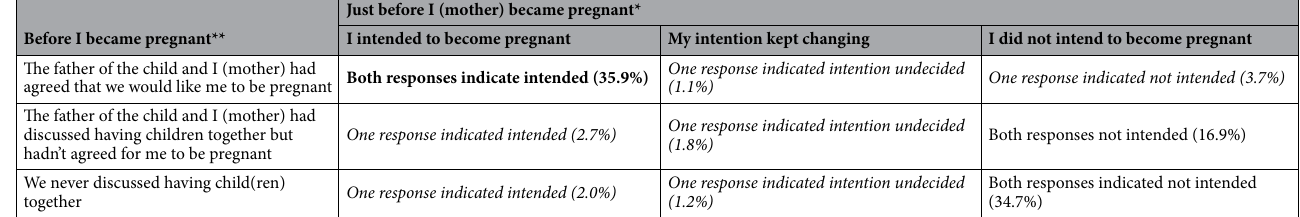
Table 1. London measure of unplanned pregnancy (LMUP) questions and categorization of responses in the 2019 South African National Antenatal HIV Sentinel Survey. *The percentages in bracket shows the